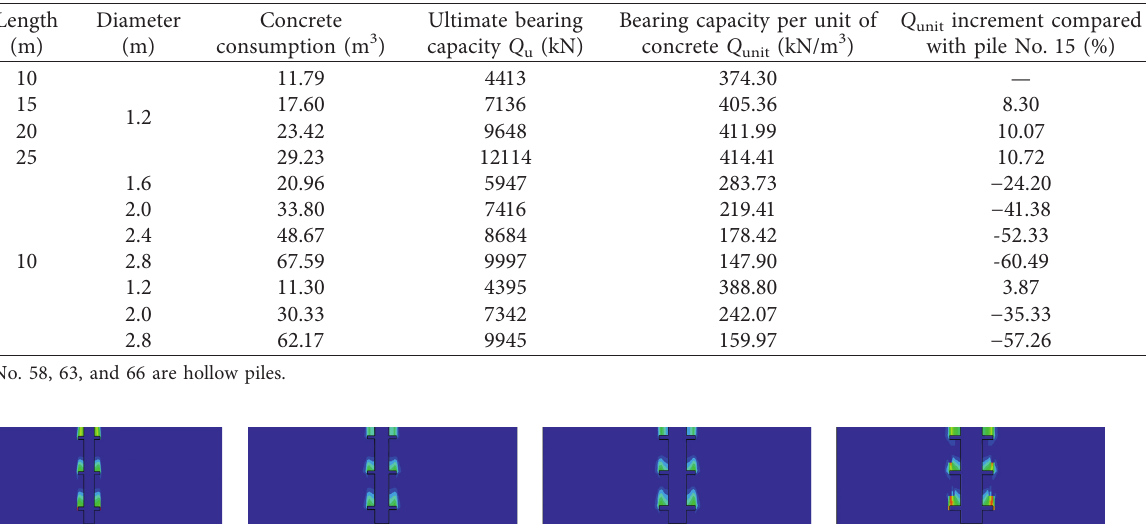
Table 6: The influence of pile length and diameter and hollow sections on the bearing capacity.